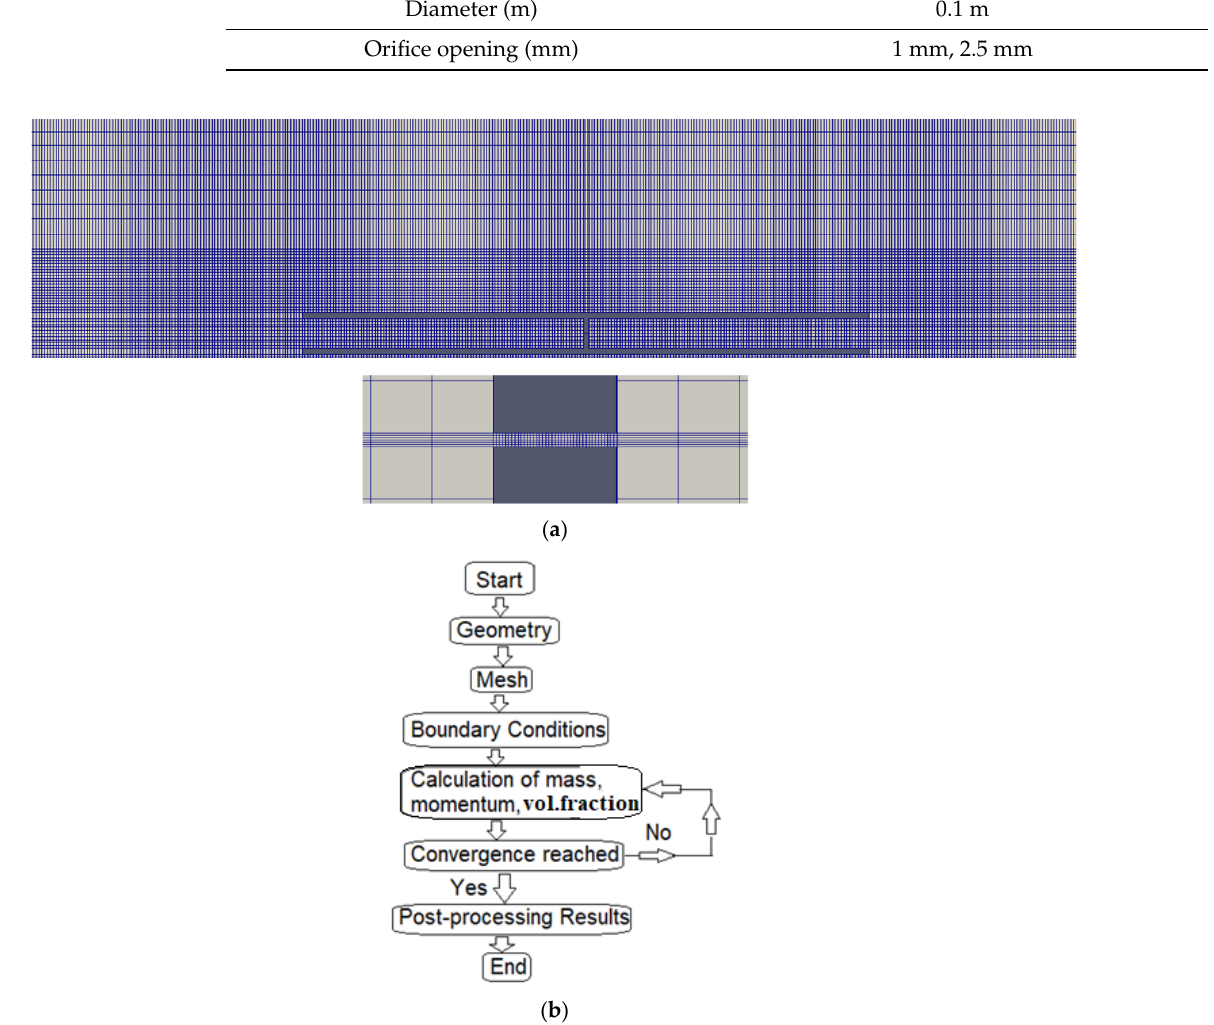
Figure 2. ( a ) Mesh distribution in the computation domain (top). Meshes are concentrated inside the orifice (bottom). ( b ) Flow chart indicating the CFD methodology.